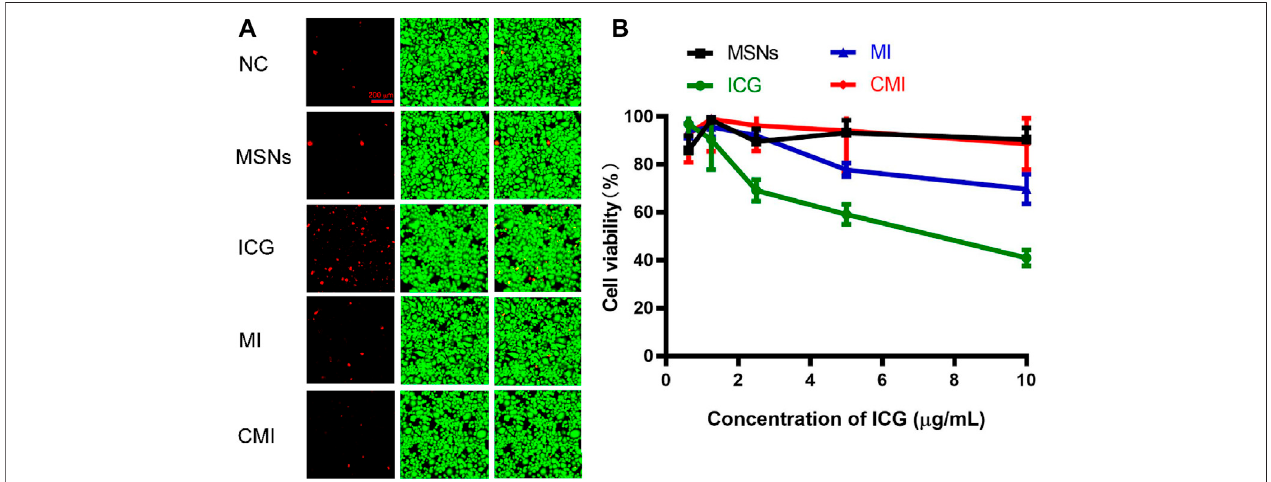
FIGURE 4 | In vitro cytotoxicity of Hela cells treated with free ICG and MSN-based nanoparticles for 48 h. (A) Live/dead assay of Hela cells treated with different nanoparticles at an ICG concentration of 10 μ g/ml. (B) CCK-8 assay of Hela cells treated with MSN-based nanoparticles with different ICG concentrations. Data are represented as mean ± SD ( n (cid:2)